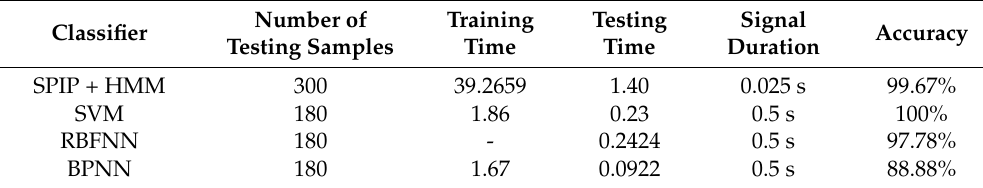
Table 9. Performance of machine learning